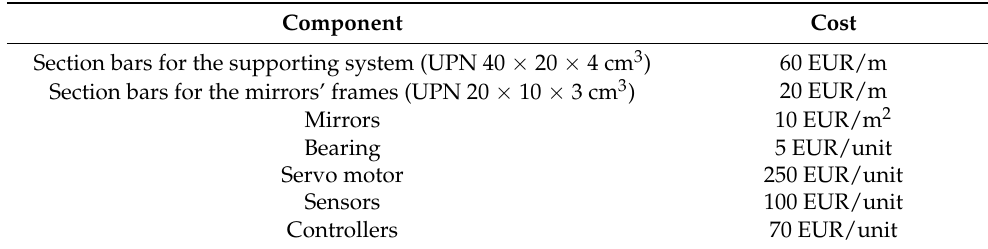
Table A1. List of the estimated costs for each sub-component of the optical system. UPN refers to the European standard U.